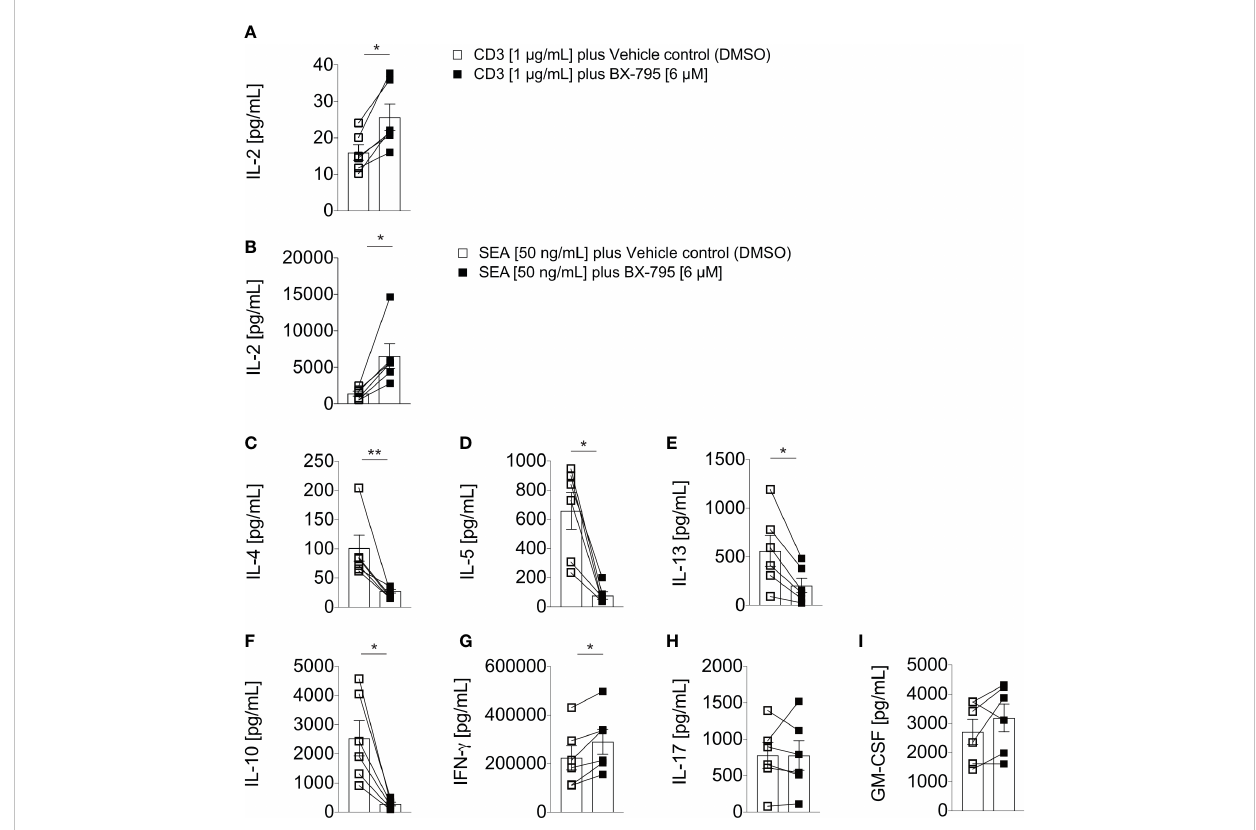
FIGURE 2 BX-795 stimulates IL-2 but inhibits Th2 effector cytokine secretion in primary human peripheral blood T cells. Shown are (A, B) , IL-2; (C) , IL-4; (D) , IL-5; (E) , IL-13; (F) , IL-10; (G) , IFN- g ; (H) , IL-17; and (I) , GM-CSF; levels in supernatants of human PBMC (1x10 5 /well) which were stimulated in 96-well round bottom tissue culture plates with soluble 1 µg/mL CD3 mAb in A, or 50 ng/mL SEA in B to I in the presence or absence of 6 µM BX-795 for 72 hours. All cultures contained DMSO at a fi nal concentration of 0.25% (v/v). Shown are A to I, the summaries (mean values ± SEM) of secreted cytokine levels obtained with PBMC of six unrelated healthy individuals analyzed in two independently performed experiments. The non-stimulated baseline levels for the indicated cytokines for medium plus DMSO and medium plus BX-795 solubilized in DMSO were (mean ± SEM): IL-2: 10.1 ± 3.1 and 8.8 ± 3.7; IL-4: 23.5 ± 2.6 and 26.7 ± 3.3; IL-5: 1.6 ± 1.0 and 0.8 ± 0.1; IL-13: 3.9 ± 1.8 and 2.3 ± 0.5; IL-10, 6.9 ± 1.3 and 8.8 ± 1.8; IFN- g : 233.7 ± 63.9 and 111.3 ± 43.0; IL-17A: 1.2 ± 0.3 and 1.2 ± 0.2 and GM-CSF: 16.0 ± 3.9 and 7.9 ± 3.2; respectively. Paired two-tailed Mann-Whitney U-test. Only statistically signi fi cant changes are indicated with *, p < 0.05; **, p <